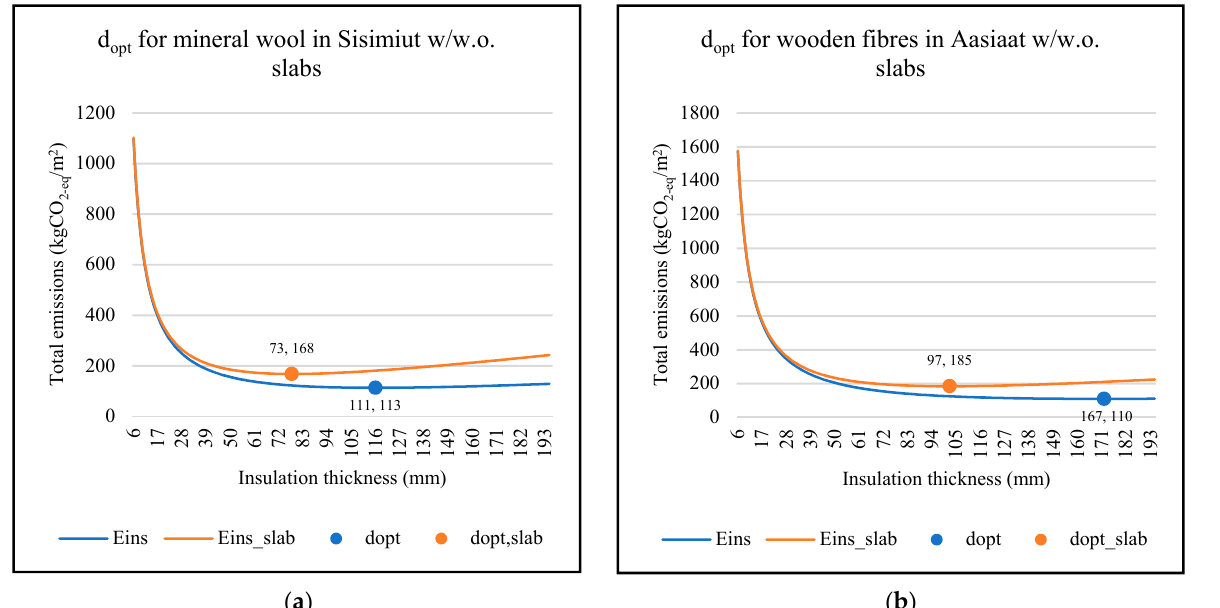
Figure 7. Graphs comparing dopt for two cases with and without slabs. (a) is for mineral wool in Sisimiut and (b) is for Wooden fibers in Aasiaat. The format of the point labels is “ d opt ; E opt ”. The pre- sets are: h = 3, n = 2, incineration, ESL = 60 years, W material = 5% and W heat = 5%. The considered slab type is in situ casted concrete (Type B).